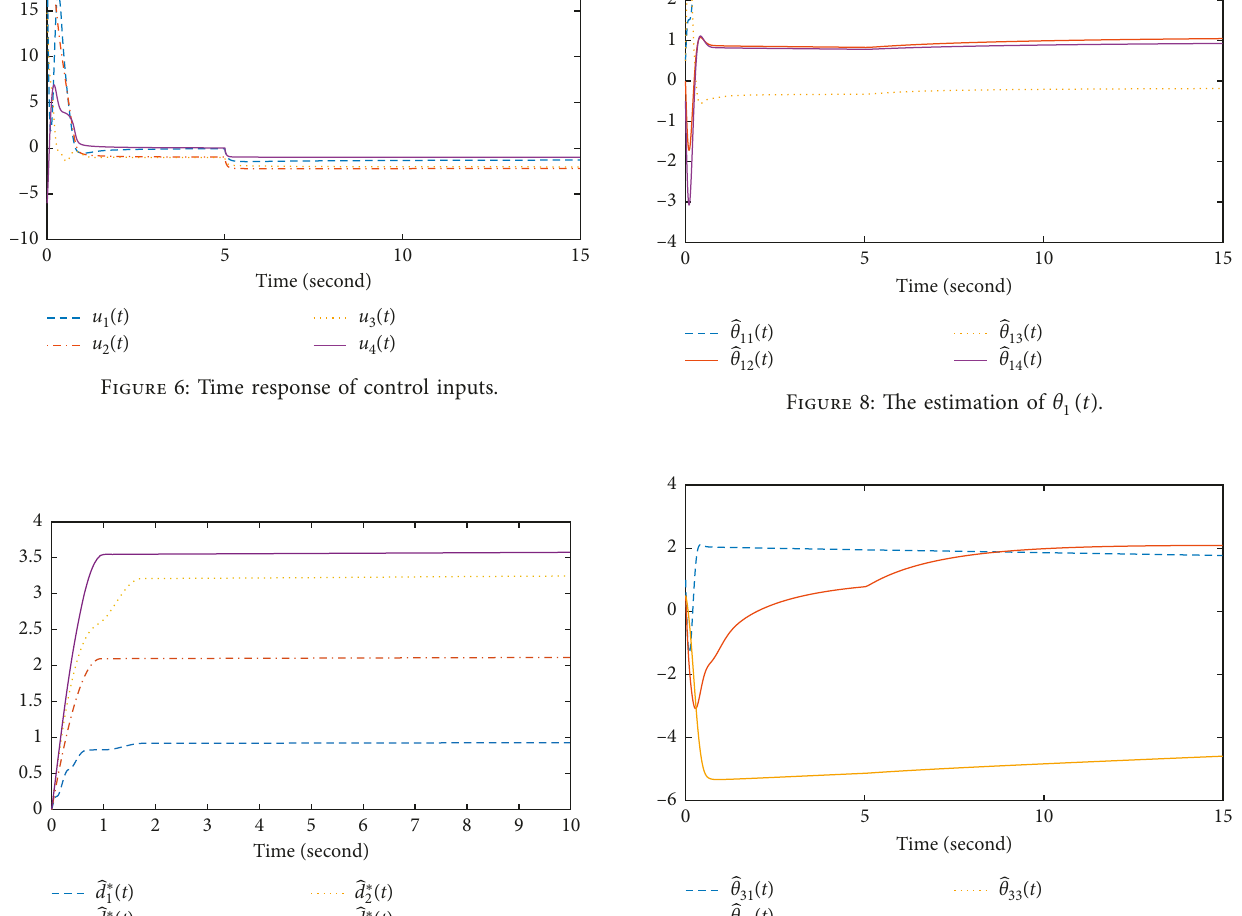
Figure 9: The estimation of θ